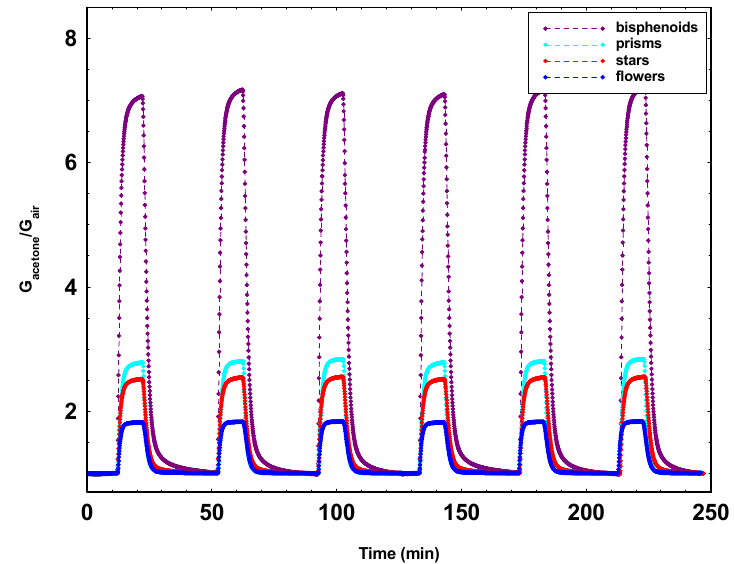
Figure 8. Dynamical responses to 0 and 1 ppm of acetone alternately for a bisphenoid’s, a star’s, a prism’s, and a flower’s sensors (operation temperature of 450 °C).